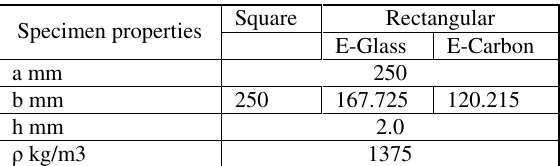
Table 1. Geometry of specimens